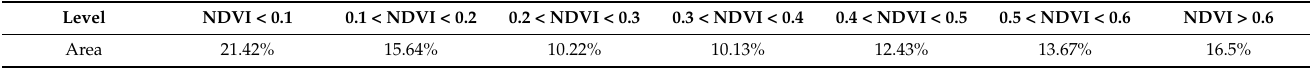
Figure 5. Vegetation interannual variation trend: ( a ) mean NDVI; ( b ) NDVI variation trend. Combining ground observations of the study area with research on arid and semiarid areas, the NDVI values across China were divided into seven grades (Table 2). NDVI > 0.1 accounted for 78.58% of the total study area; however, the overall vegetation coverage of the study area was low, with an average NDVI of only 0.34. NDVI > 0.4 accounted for 42.79% of the total area, with the vegetation type under this grade being dominated by forested land. A total of 16.5% of the total area was occupied by areas with NDVI > 0.6, and the vegetation types under this class were mainly grassland and cropland. The nonvegetated area (NDVI < 0.1) accounted for 21.72% of the total area, mainly composed of construction land and lakes, as well as the Gobi and other deserts. Table 2. Area NDVI statistics for each grade.